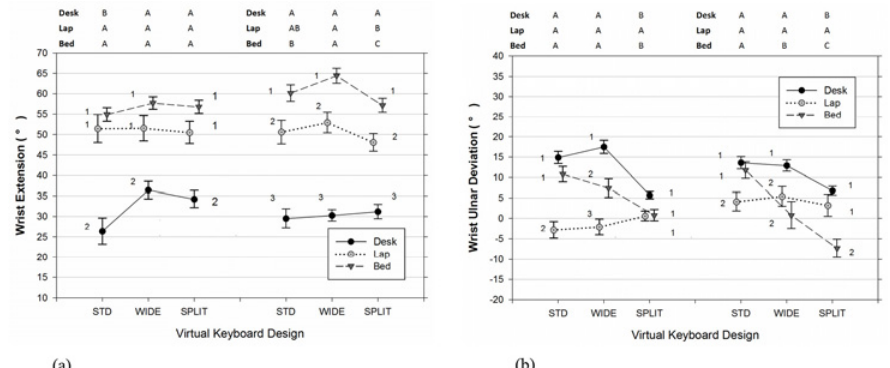
Fig 3. Wrist (a) extension and (b) deviation postures (50 th percentile) varied across different positions of tablet usage and virtual keyboard designs. Error bars represent +/- 1 SE. Negative values in (b) represent the wrist deviate toward the radial side. The conditions observed from the left (non-dominant) and right (dominant) wrist are separated accordingly in each sub figure. Conditions with the same number (1, 2, 3) denote groups without significant difference across the usage positions within the same virtual keyboard design. Conditions with the same character (A, B, C) denote groups without significant difference across the keyboard designs within the same usage